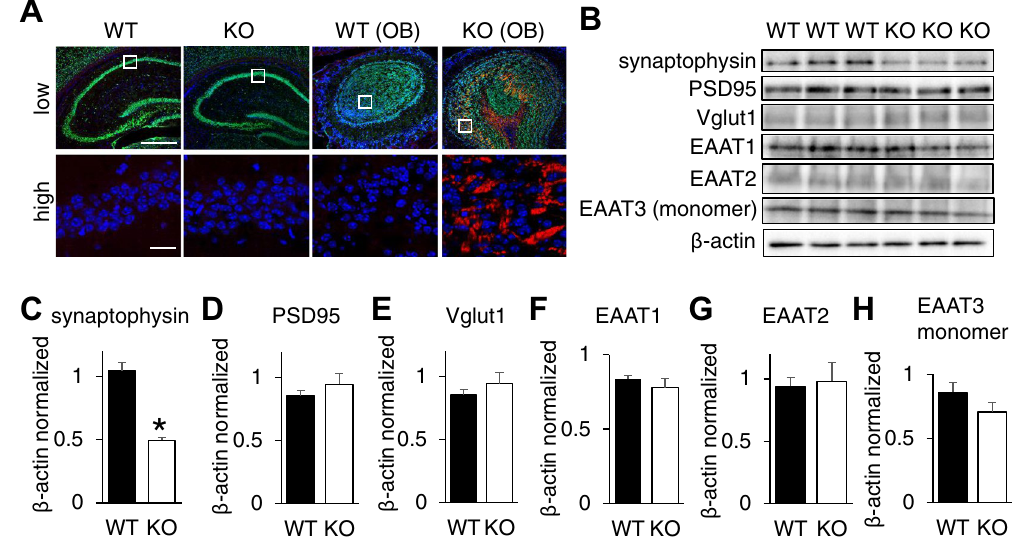
Figure 3. Ndufs4 deficiency shows altered synaptic protein expression without neuronal loss. ( A ) Representative image of co-immunofluorescence staining of NeuN and Caspase 3 in hippocampus and olfactory bulb (OB) of WT mouse and Ndufs4-KO. Insets enlarge the boxed area. Low magnification green indicates NeuN and red indicates caspase 3, scale bar: 400 µm. In high magnification red indicates caspase 3 with no green stain, scale: 20 µm. ( B ) Representative images of Western blot for synaptophysin, PSD95, Vglut1, EAAT1, EAAT2, EAAT3 in WT and Ndufs4-KO mouse hippocampus. ( C – H ) Analysis of band densities by ImageJ (n =